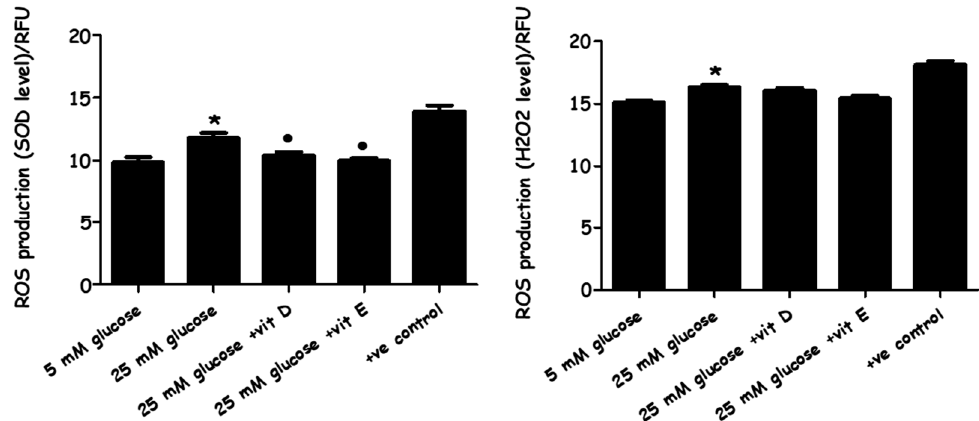
Figure 5. The effect of high-glucose media alone, with vitamin D, and with vitamin E on reactive oxygen species (ROS) production. PASMC cells were incubated with normal (five mM) and high glucose (25 mM) for 72 h. Vitamin D (80 ng/mL) and vitamin E (nine µg/mL) were added immediately along with high-glucose incubation. Superoxide (O 2 · − ) levels and hydrogen peroxide (H 2 O 2 ) levels were detected by dihydroethidium (DHE) and 2 ′ , 7 ′ -dichlorofluorescein (DCF) fluorescence compound, respectively. * p < 0.05 vs. unstimulated cells ( n = 4). * p < 0.05 vs. cells cultured in normal